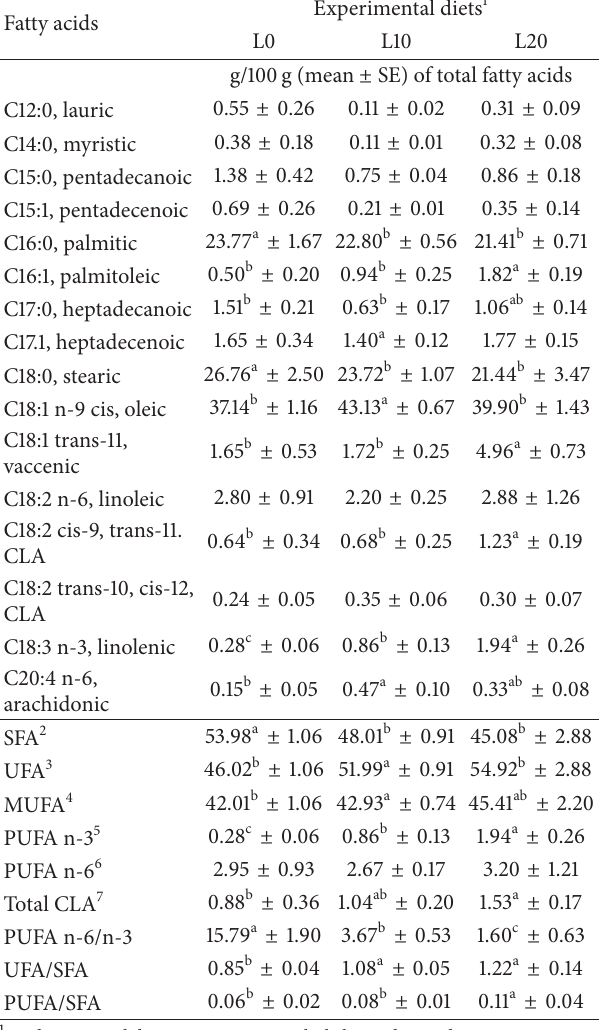
Table 5: Fatty acid profiles ofthe semitendinosus muscle of goats fed diets containing different levels of whole linseed.